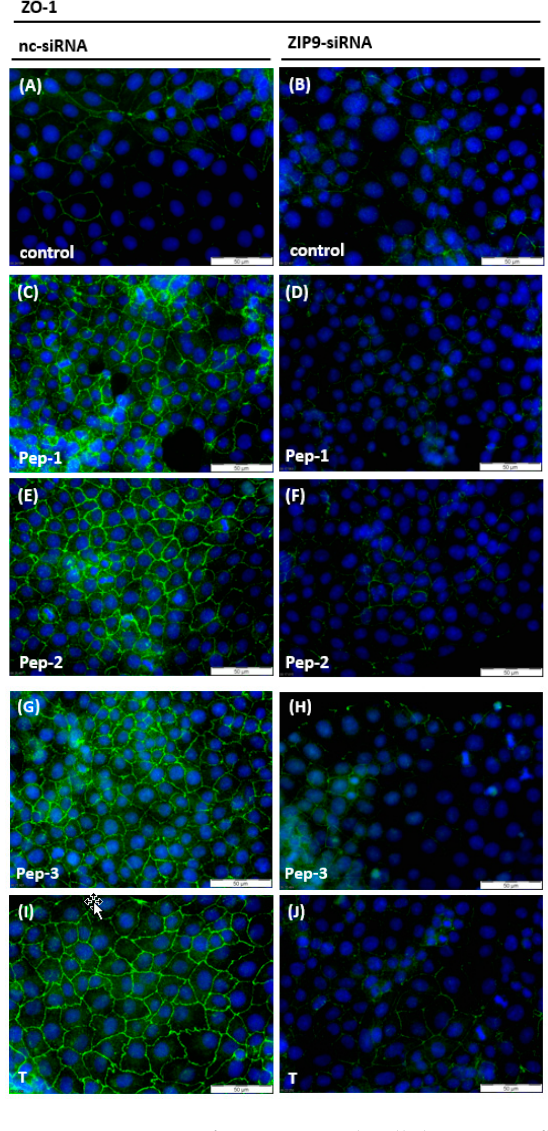
Figure 7. Detection of ZO-1 in Sertoli cells by immunofluorescence. Nuclei are stained blue, ZO-1 is visible as green fluorescence. ( A , B ) Unstimulated 93RS2 cells treated with nc-siRNA or ZIP9-specific siRNA show basal level of ZO-1 expression. ( C , E , G , I ) Cells that are treated with nc-siRNA and stimulated with peptides (10 µM) or testosterone (10 nM) for 24 h show increased staining of ZO-1 at their plasma membranes. ( D , F , H , J ) Cells treated with ZIP9-siRNA did not respond to peptide or testosterone treatment by increasing ZO-1 expression.